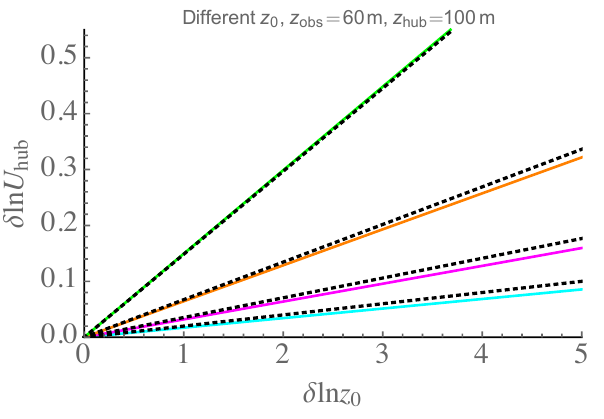
Figure A1. Equation (6) (solid) and its approximation, Eq. (A1) (dotted), for different (correctly observed) background roughnesses z 0,obs . Cyan: z 0 , 1 = 0.001m; magenta: z 0 , 1 = 0.01m; orange: z 0 , 1 = 0.1m; green: z 0 , 1 =